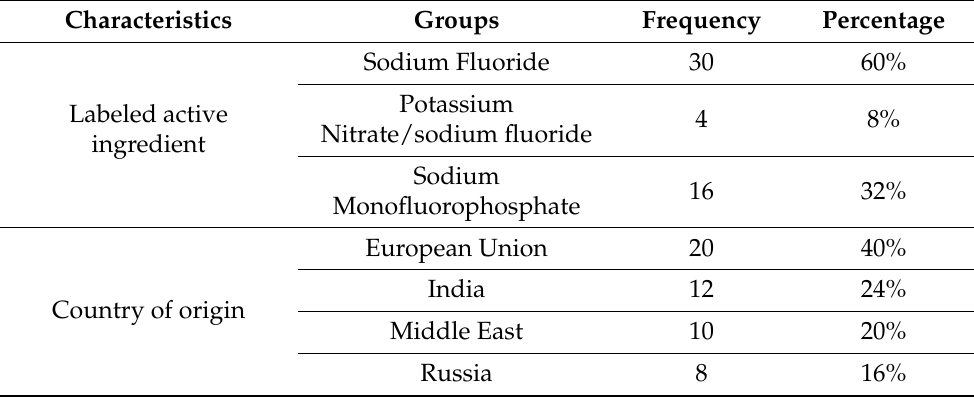
Table 1. Number and Percentages of Sample Baseline Characteristics ( n =